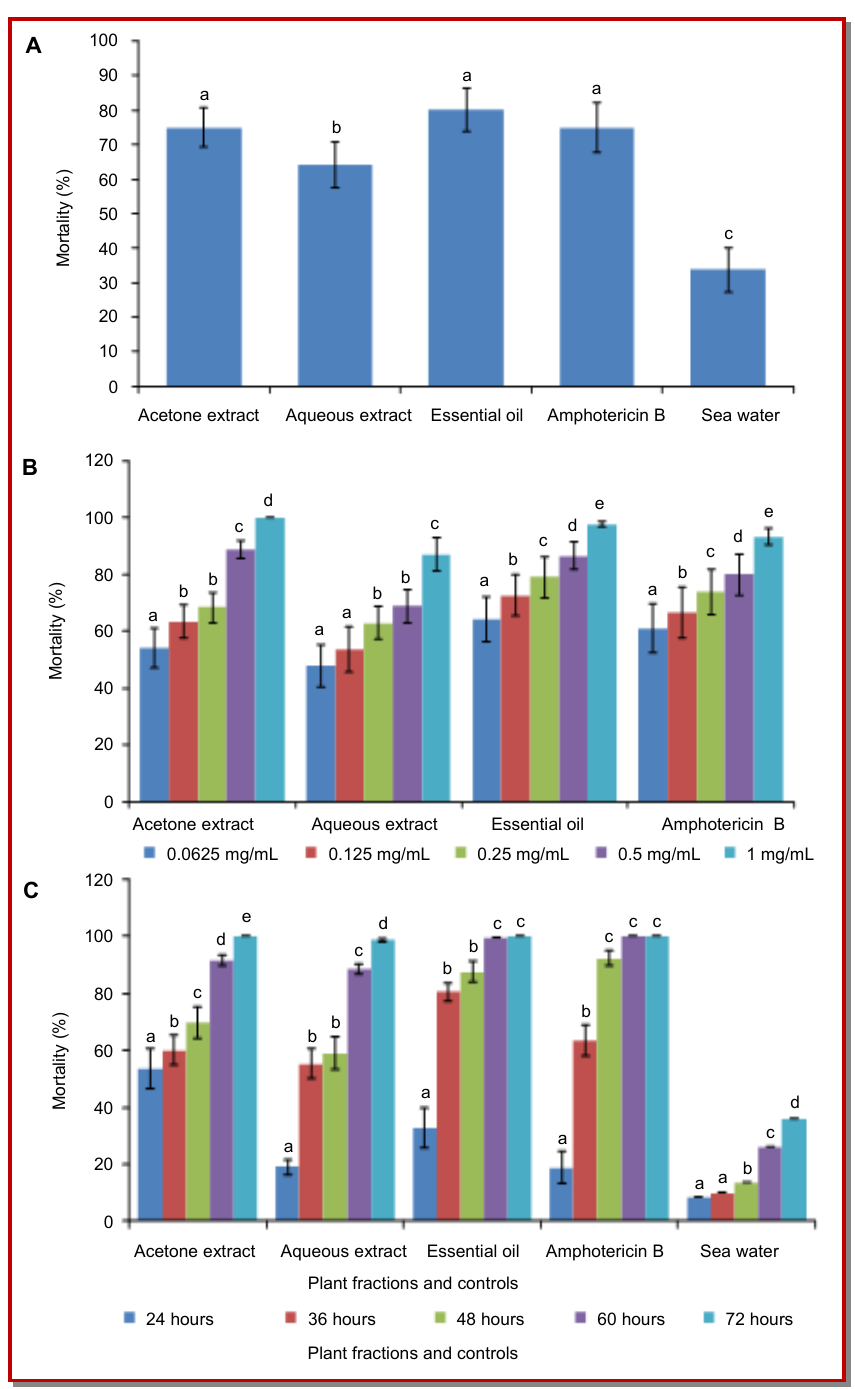
Figure 2: Percentage mortality of A. salina nauplii. (A) Incubated in different plant fractions and controls; (B) In different concen- trations of the plant extracts and control; (C) In different durations in the plant fractions and controls. The values are means of experiments/concentrations for each plant fraction/control ± SD of three replicates. Percentage mortality of fraction/control marked with different letters is significantly different